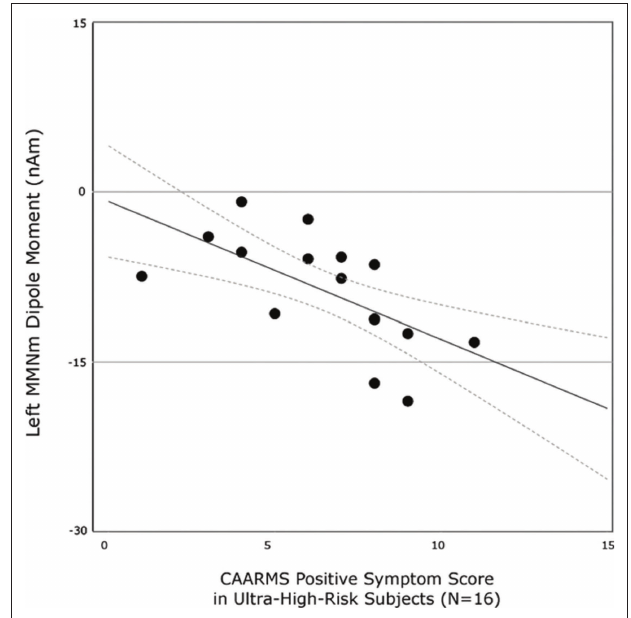
Figure  | Correlations between MMN measures in patients during the prodromal phase of the disorder with an assessment of ultra-high risk state (CAArMS). A negative relationship is seen between MMN strength and ranking on the CAARMS metric. Reproduced, with permission, from Shin et al.